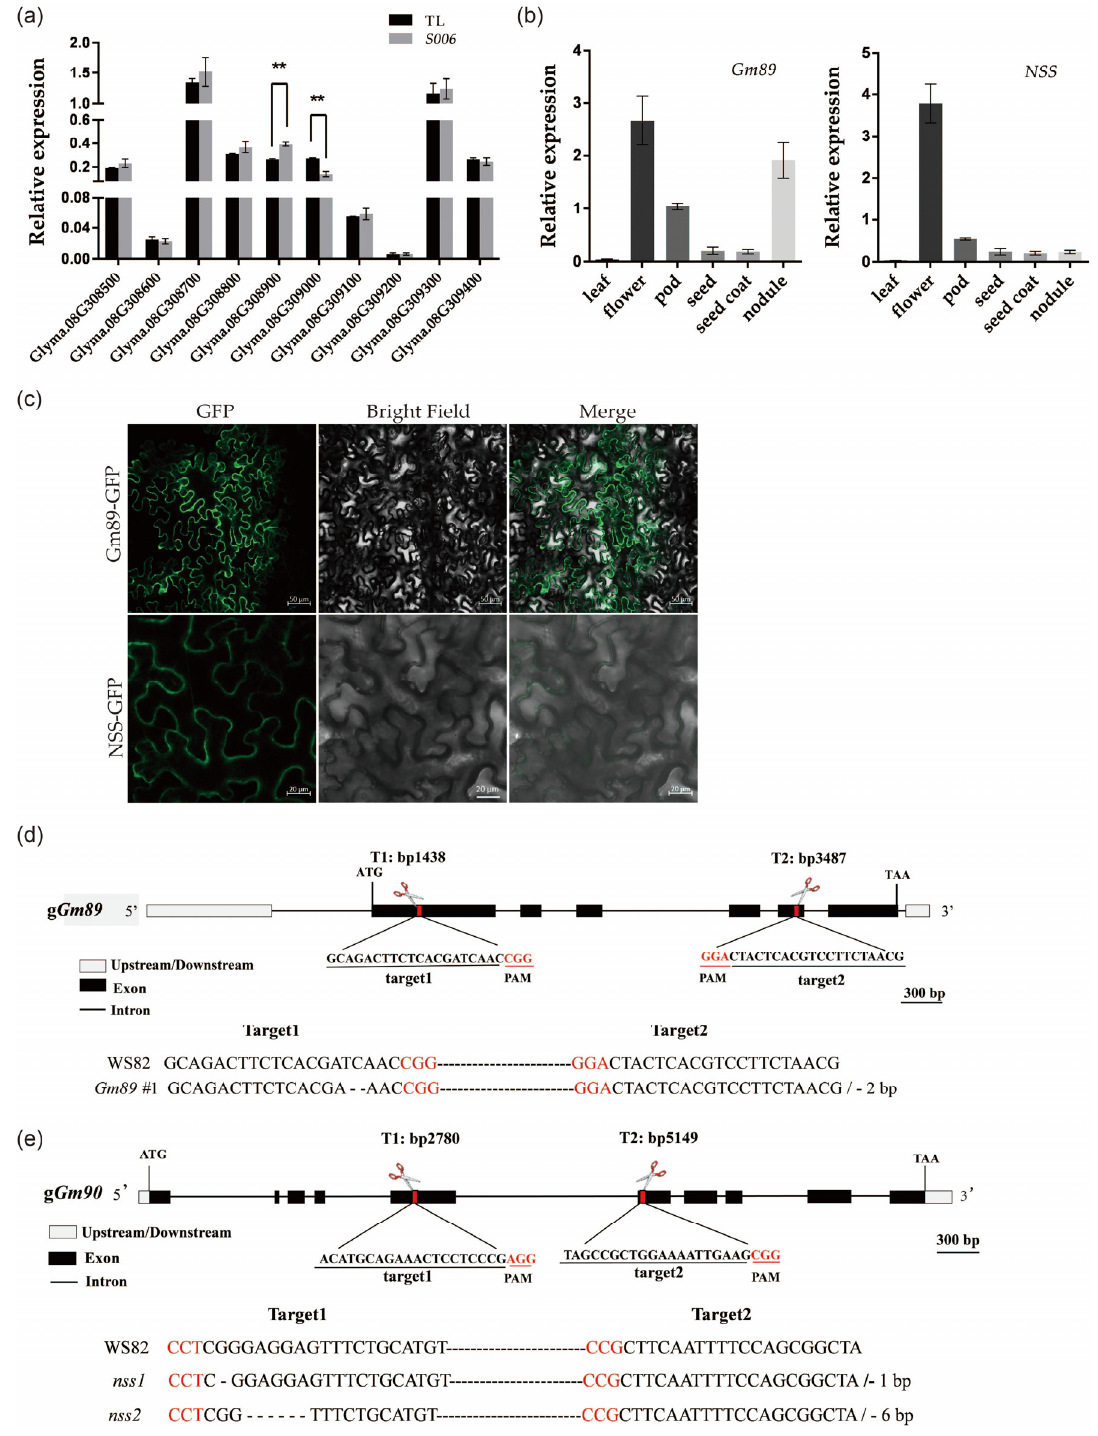
Figure 5. Expression patterns, protein subcellular localization, and mutant constructions of Gm89 and NSS genes. ( a ) Flanking-gene expressions of T-DNA insertion site in S006 mutant. Asterisks indicate a significant difference according to Student’s t -test (**, p < 0.01); ( b ) expression patterns of Gm89 and NSS . ( c ) subcellular localization of Gm89 and NSS proteins. Bars for upper row = 50 μ m, bars for lower row = 20 μ m; ( d ) identification of Gm89 mutant. The red letters represent the PAM site; ( e ) identification of nss mutants. The red letters represent the PAM site.